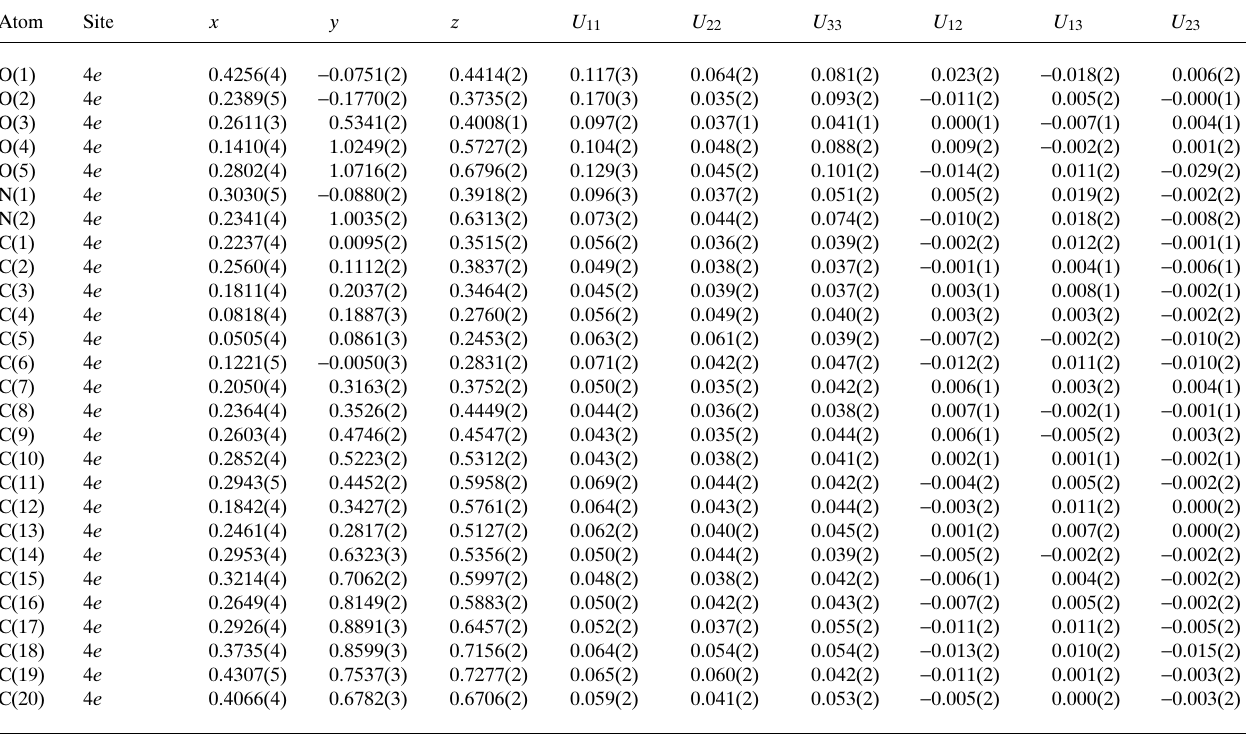
Table 3. Atomic coordinates and displacement parameters (in Å 2 ) .